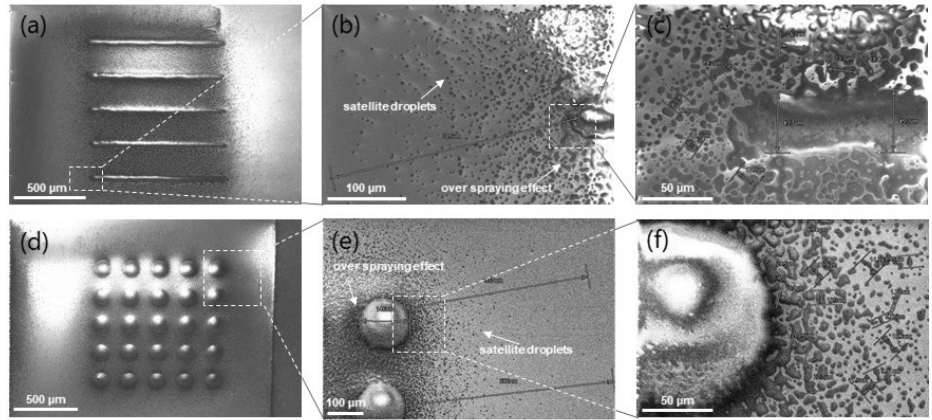
Figure 5. Top view of printed mono-layers. ( a ) Line and ( d ) base of pillar structures, ( b , e ) farthest droplets from the printing path, and ( c , f ) over-spray effect.